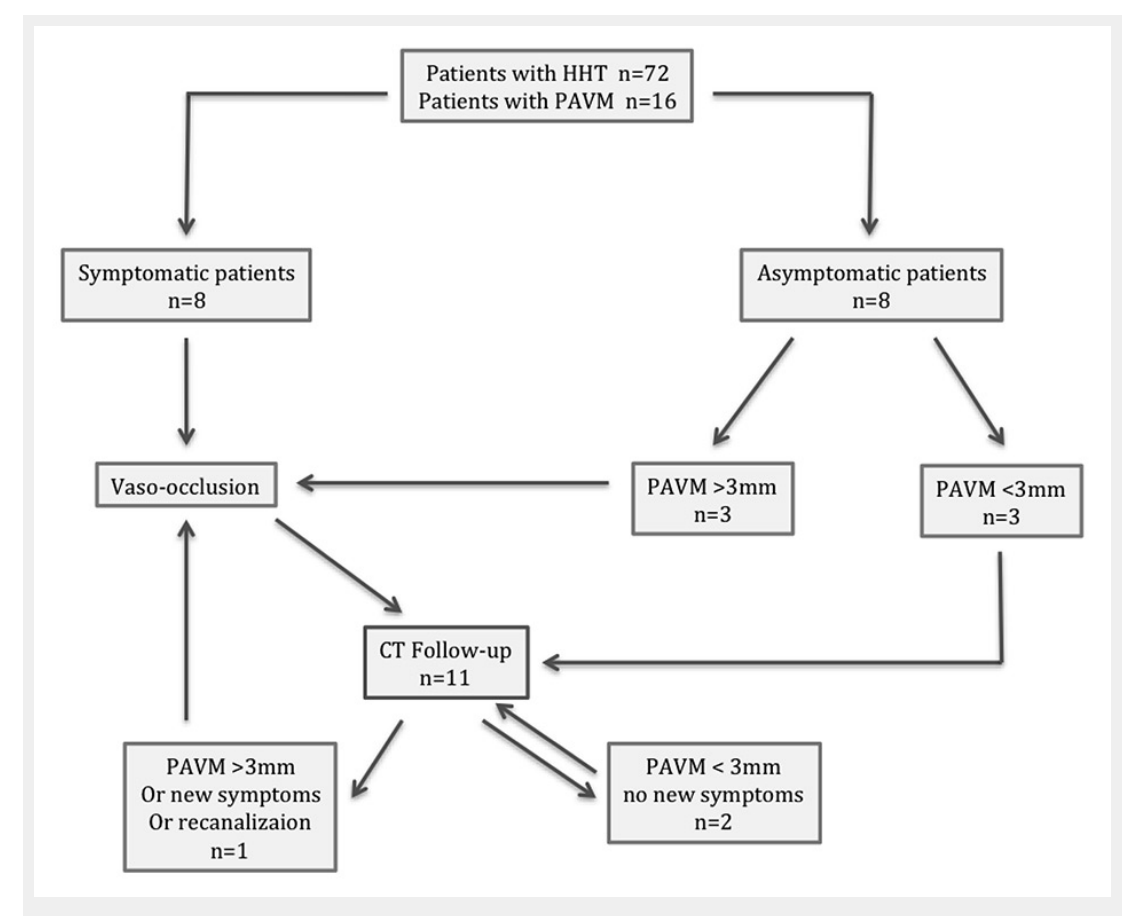
Figure 2 Treatment for symptomatic or >3 mm pulmonary arteriovenous malformations and